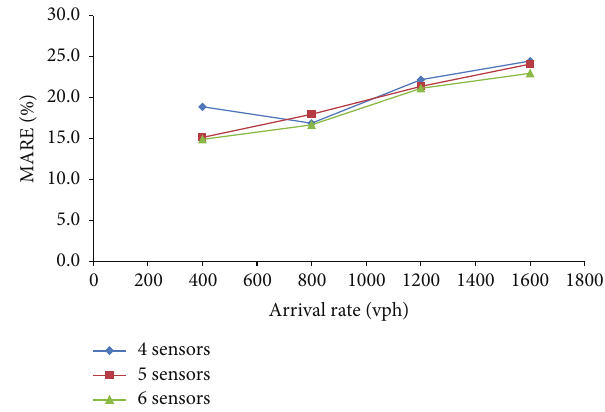
Table 3: Comparison among different arrival rates.